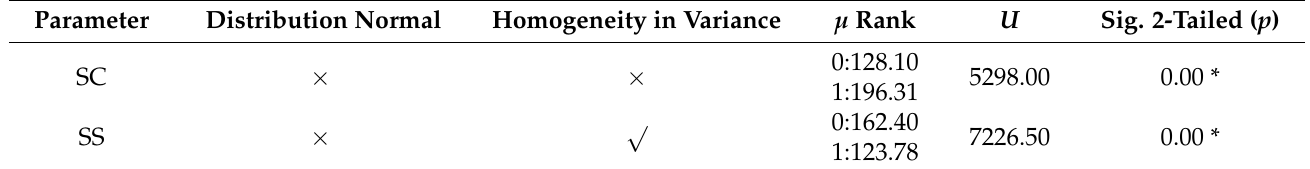
Table 7. Impact of SC and SS on Survival-Status of the Patient.